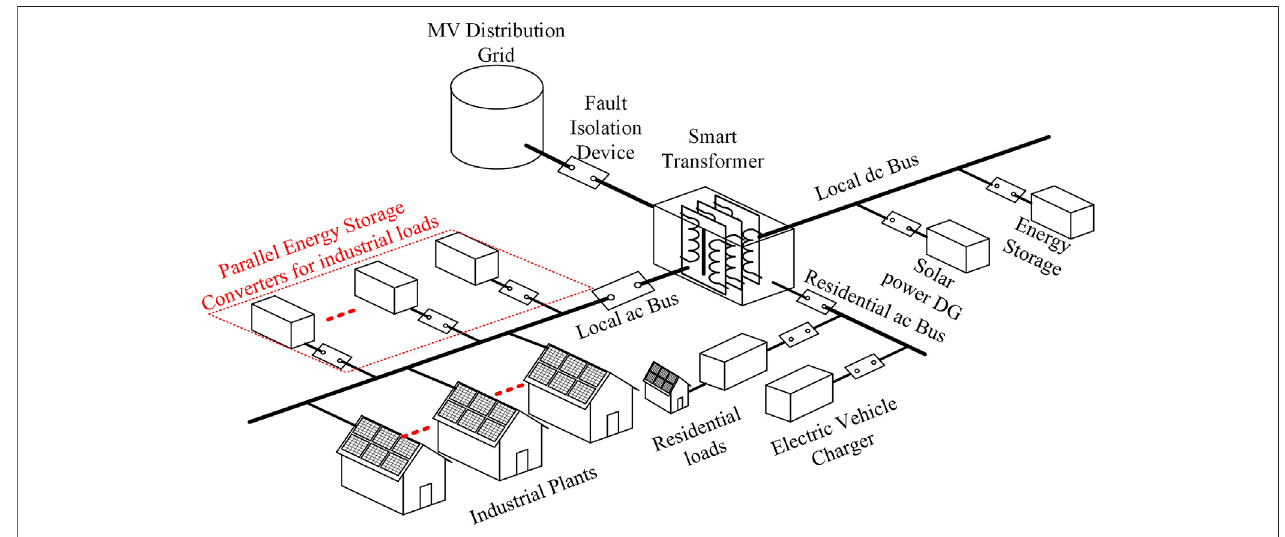
FIGURE 1 | Con fi guration of ST enabled